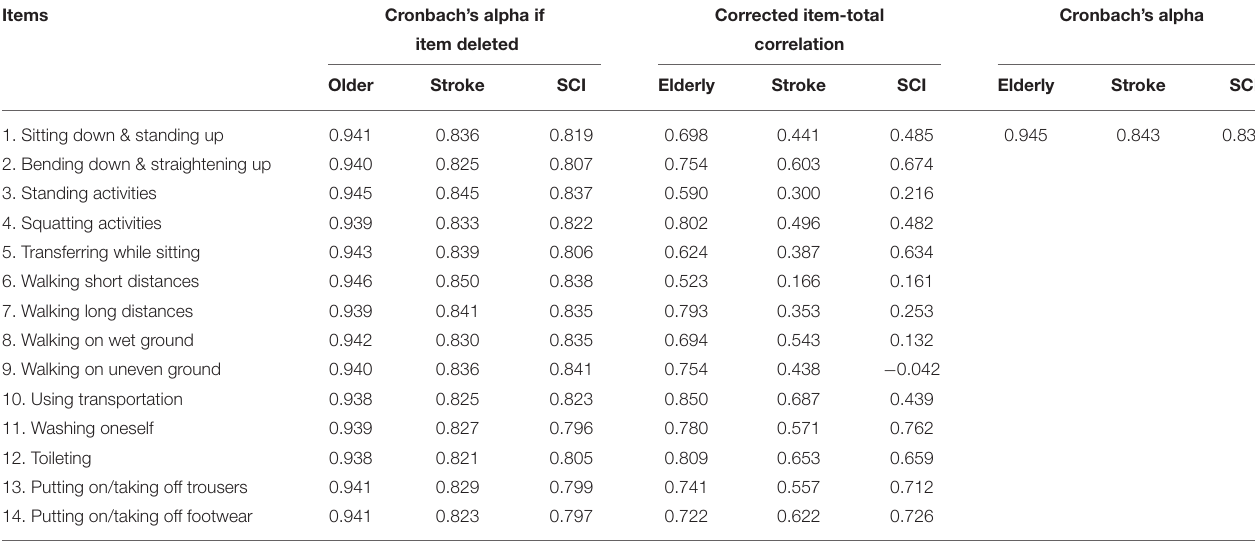
TABLE 3 | Internal consistency of the CARFS in the elderly, persons with stroke or with spinal cord injury respectively. Items Cronbach’s alpha if Corrected